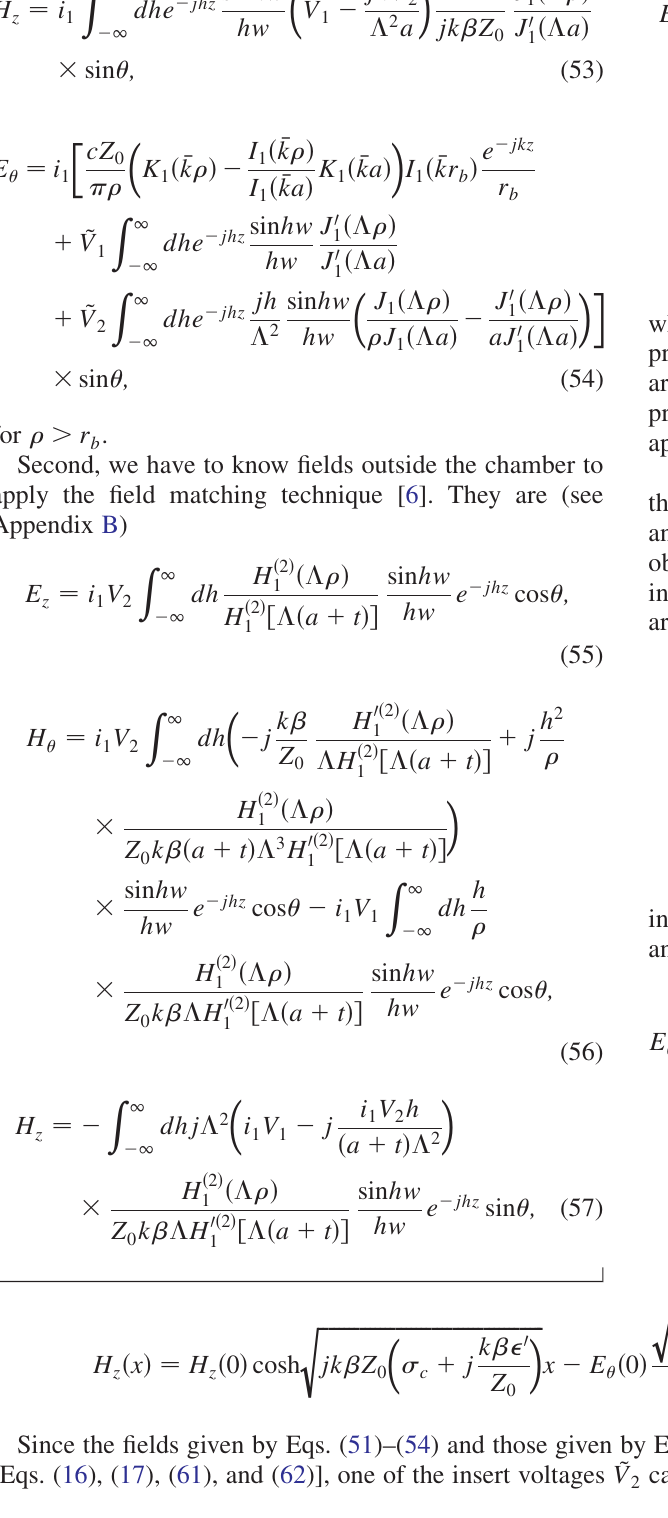
ffiffiffiffiffiffiffiffiffiffiffiffiffiffi p jk(cid:4)Z 0 (cid:1) c